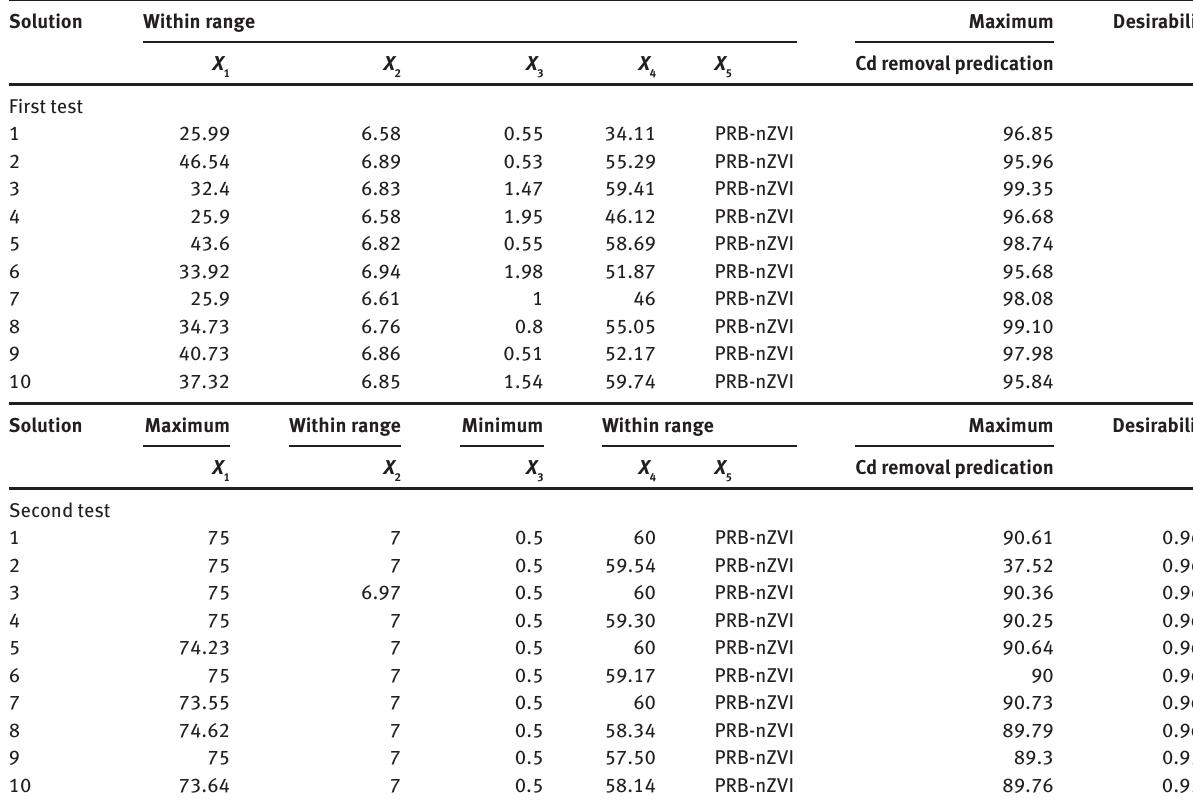
Table 4: Experimental results for model validation conducted at the optimum conditions as obtained from BBM. Solution Within